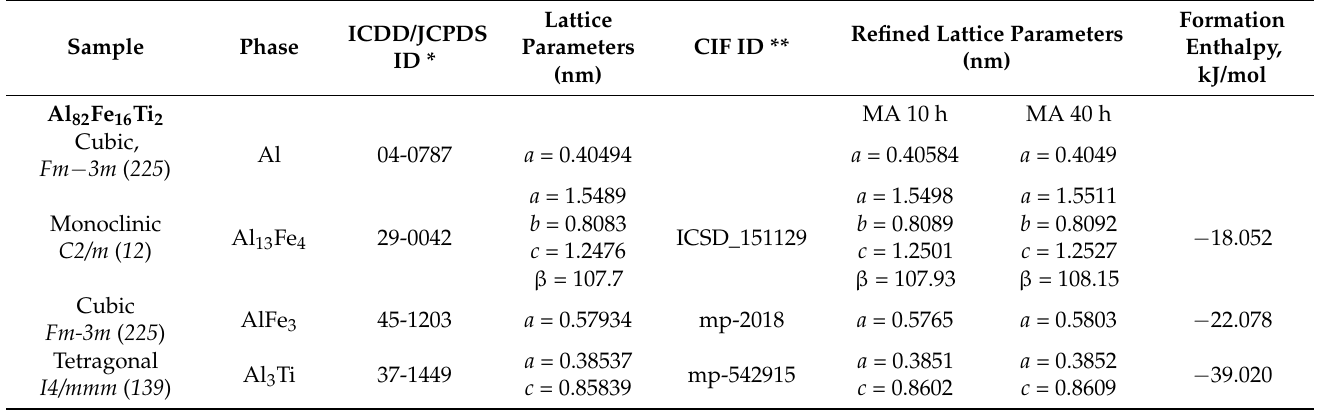
Table 3. Refined lattice parameters of crystallization phases formed from DSC-quenched Al 82 Fe 16 Ti 2 , Al 82 Fe 16 Ni 2 , and Al 82 Fe 16 Cu 2 alloy